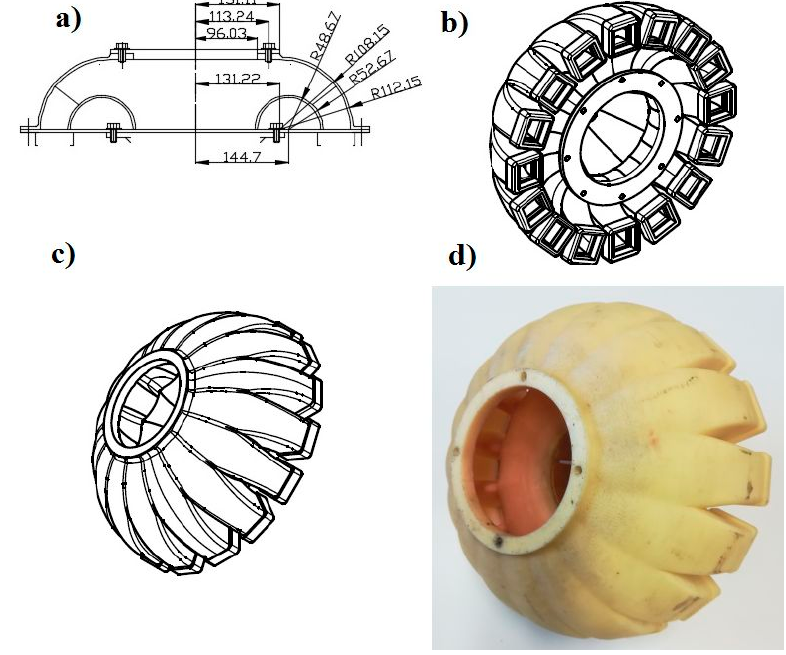
Figure 2. An innovative distributor of the seed-and-air stream in a pneumatic seed drill: ( a ) cross-sectional view of the stream diffuser with basic dimensions, ( b ) bottom view of the CAD 3D model, ( c ) top view of the CAD 3D model, ( d ) view of the stream diffuser prototype made with the rapid prototyping method.